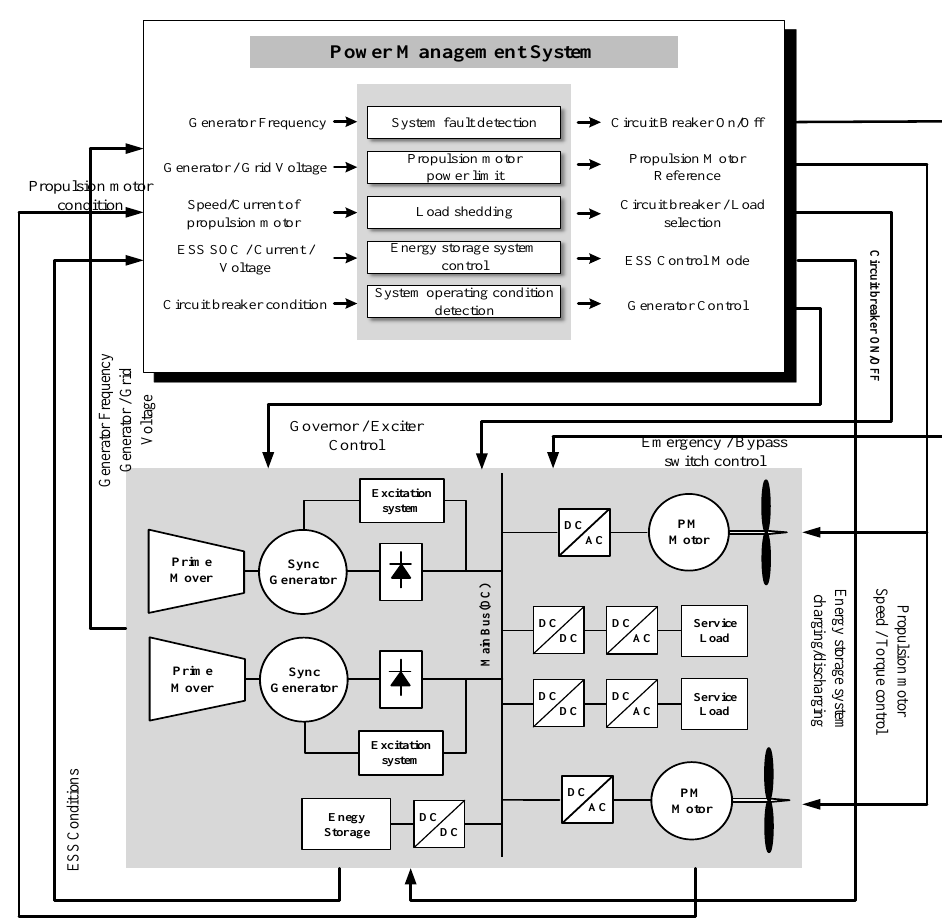
Figure 6. Configuration of the power management system.